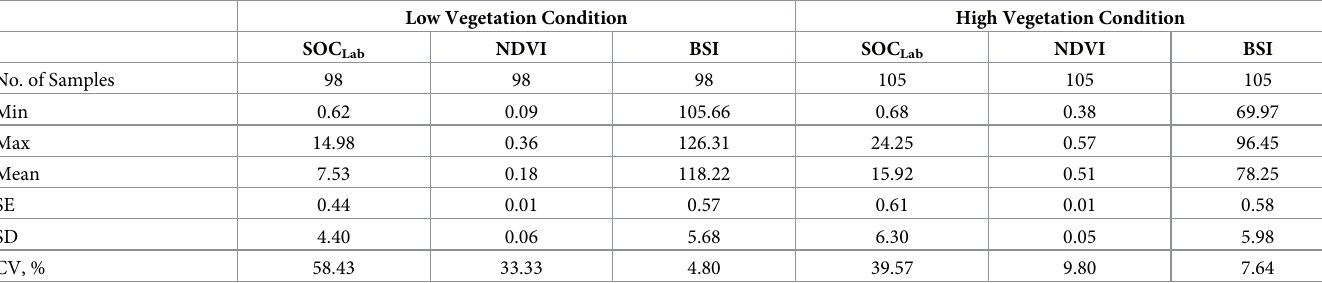
Table 4. Descriptive statistics of the lab determined SOC (g kg -1 ) and the generated VIs.